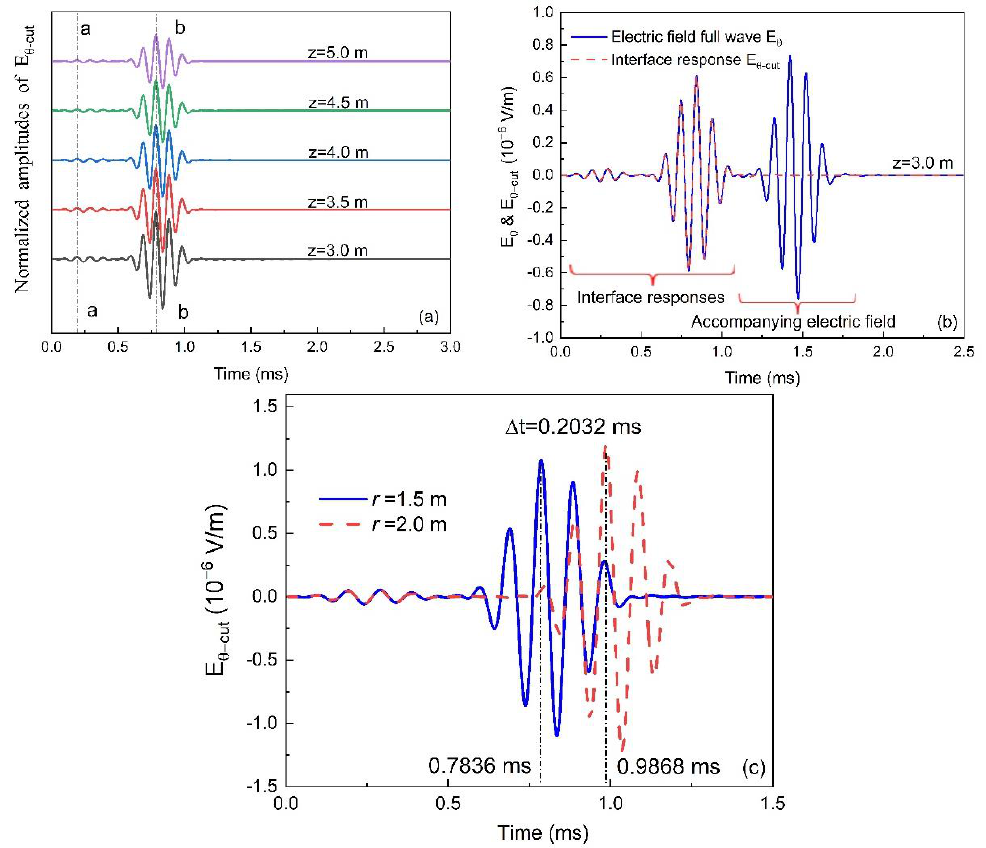
Figure 8. Interface converted electromagnetic waves. ( a ) The normalized waveforms of 𝐸 𝜃−𝑐𝑢𝑡 . ( b ) Comparison of 𝐸 𝜃 and 𝐸 𝜃−𝑐𝑢𝑡 . ( c ) 𝐸 𝜃−𝑐𝑢𝑡 for different interface positions. The components a-a and b-b are same as in Figure 7.